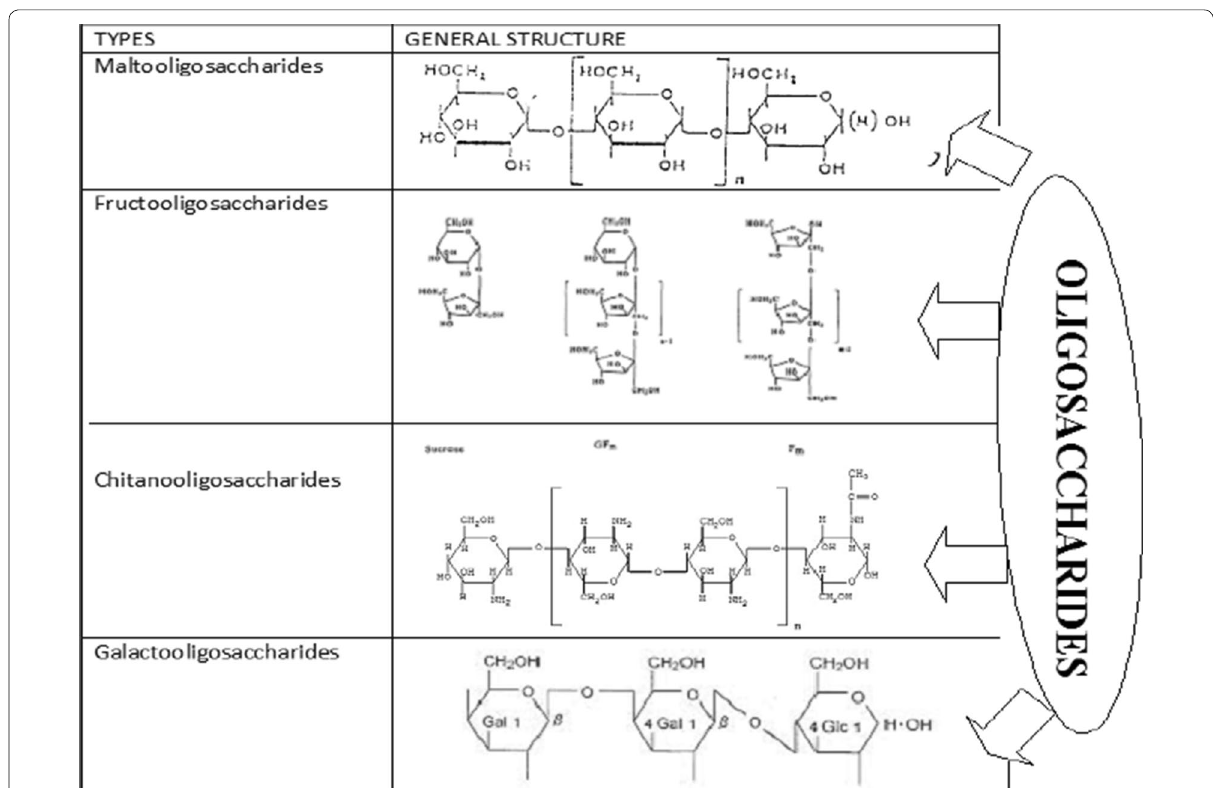
Fig. 1 Overview of structure of some common